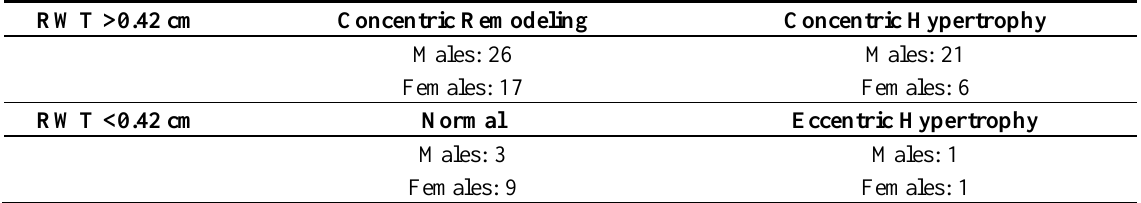
Table 4. Cardiac adaptation in the study collective